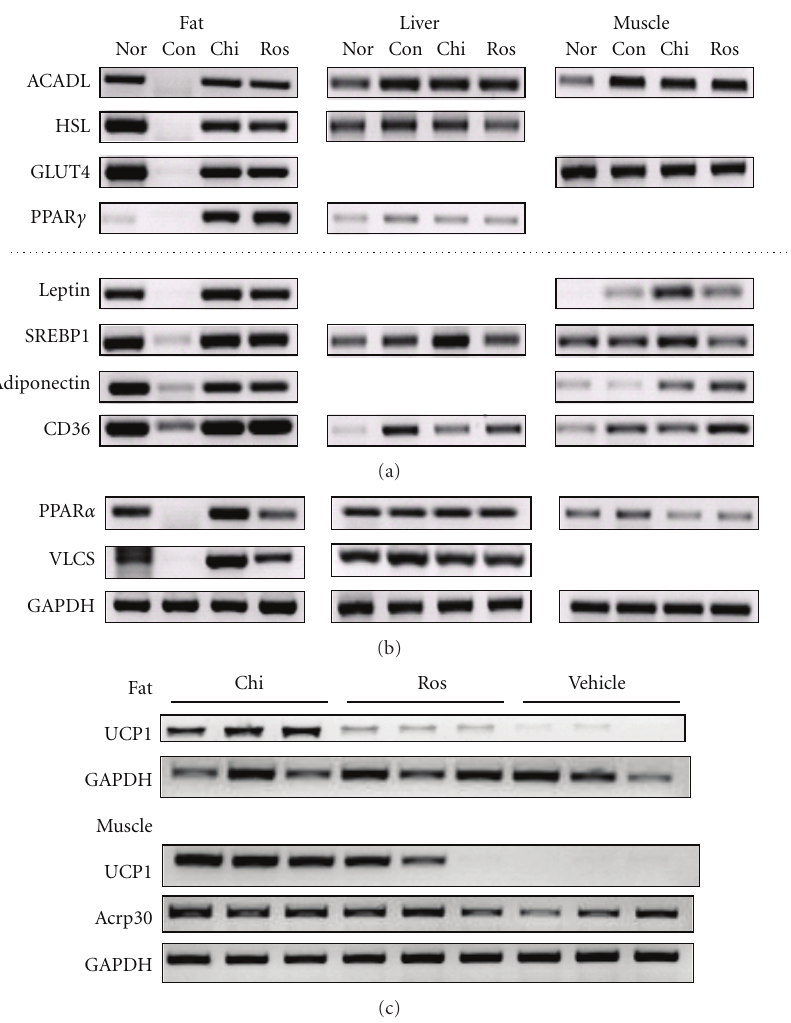
Figure 3: In vivo regulation of gene expression by chiglitazar. (a) and (b) Normal male C57BL/6J mice (Nor) and male KKAy mice were orally administered daily with vehicle (Con), chiglitazar of 20mgkg − 1 (Chi), or rosiglitazone of 5mg kg − 1 (Ros) for 12 days. 24 h after the last dosing, tissues from abdominal fat, liver, and skeletal muscle were taken from 3 mice in each group, and total RNA was isolated from individual animal tissues. Equal amount of total RNA from each mouse in the same group was mixed and subjected to RT-PCR analysis for the indicated genes. (c) Male db/db mice were orally administered daily with vehicle (Con), rosiglitazone of 5mg kg − 1 (Ros), or chiglitazar of 20mgkg − 1 (Chi) for 14 days. 24h after the last dosing, abdominal fat and skeletal muscle were taken from 3 mice in each group. Total RNA was isolated from individual animal tissues and subjected to the RT-PCR analysis independently for the indicated